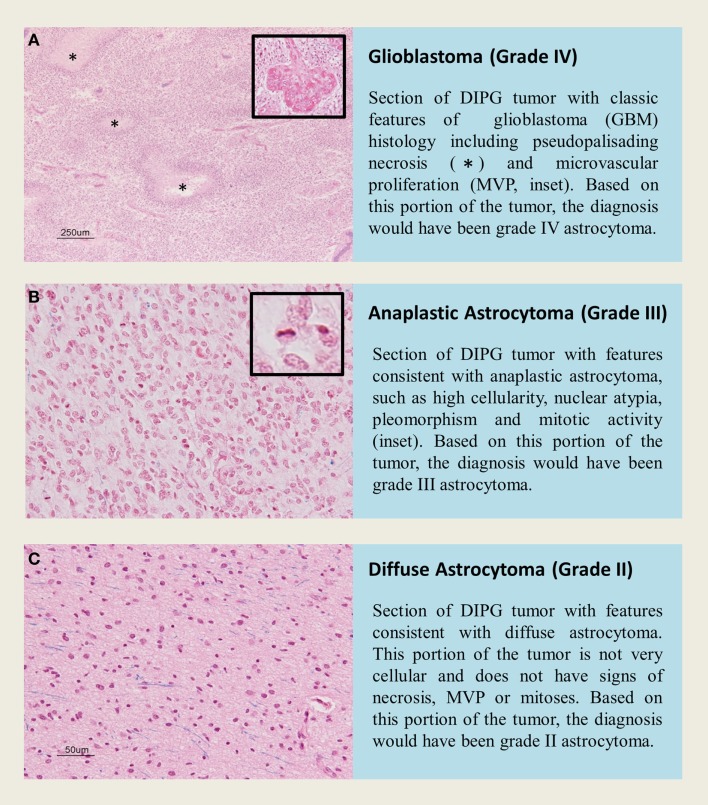
H&E staining of tissue sections from an autopsy of a K27M-H3.1 mutant diffuse intrinsic pontine glioma patient highlights vast regional differences that histologically resemble (A,B) high grade astrocytoma (WHO grade III–IV) or (C) low grade astrocytoma (WHO grade II). Inadvertently targeting these regions on biopsy could lead to misdiagnosis. Histone H3 mutation predicts overall survival better than histologic grade for DIPG. Mutational testing at the time of stereotactic biopsy should be implemented into clinical practice for DIPG patients.